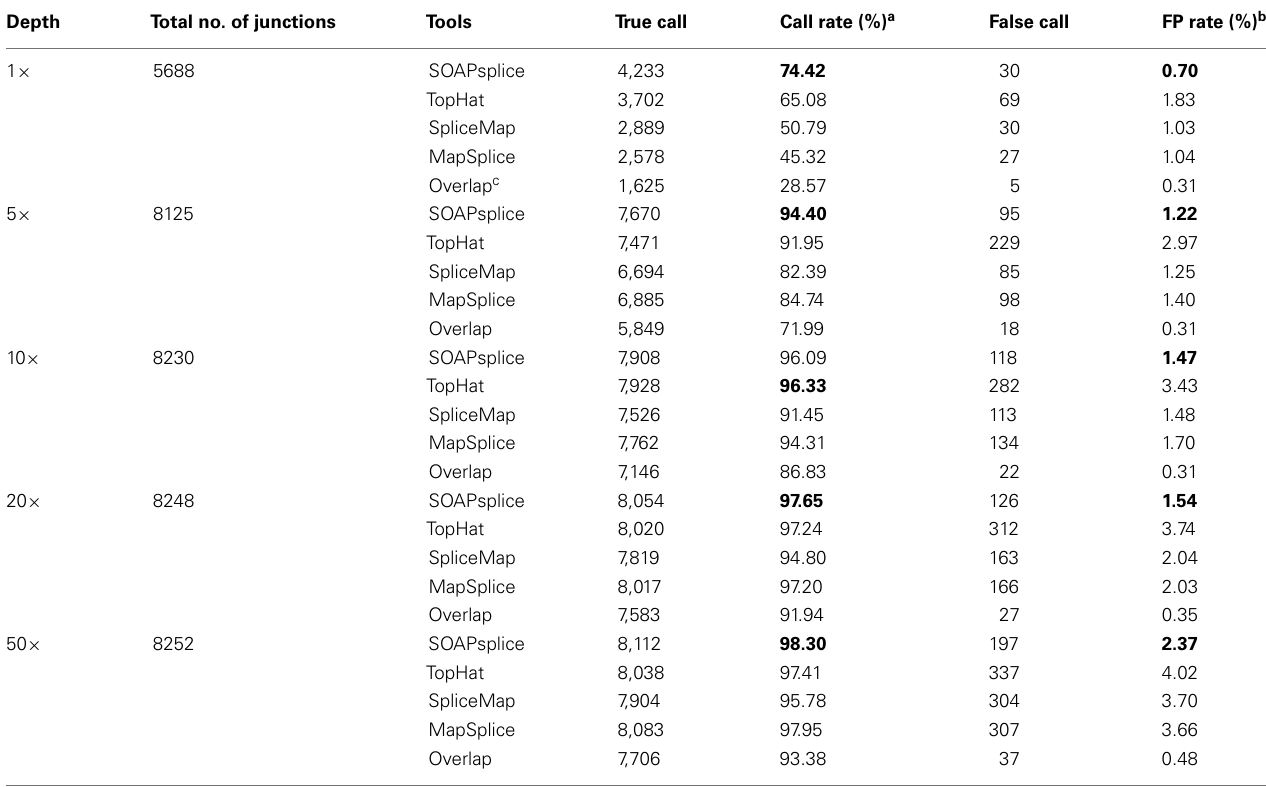
TableA4 | Statistics of the junctions detected on the 100-bp simulated reads. Depth Total no. of